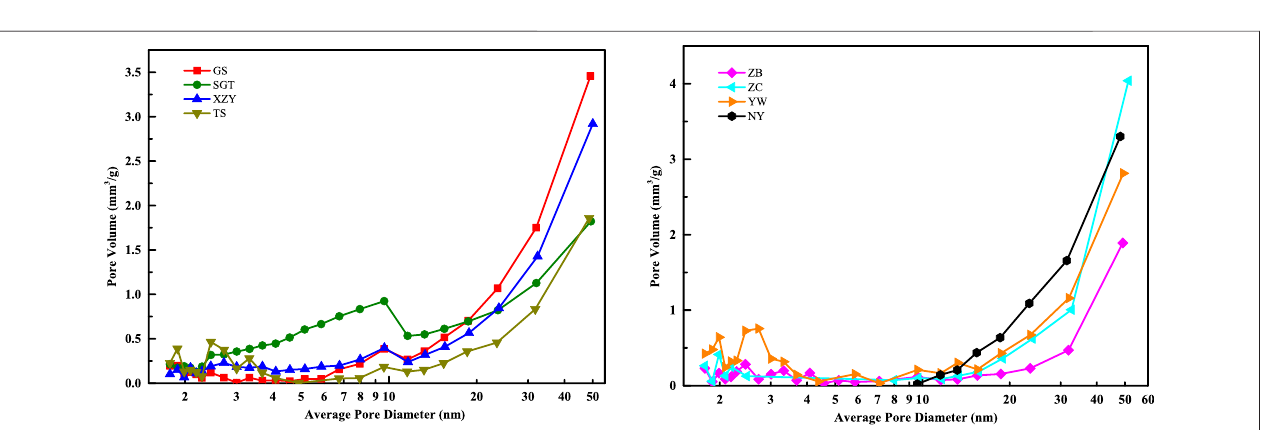
Frontiers in Earth Science |